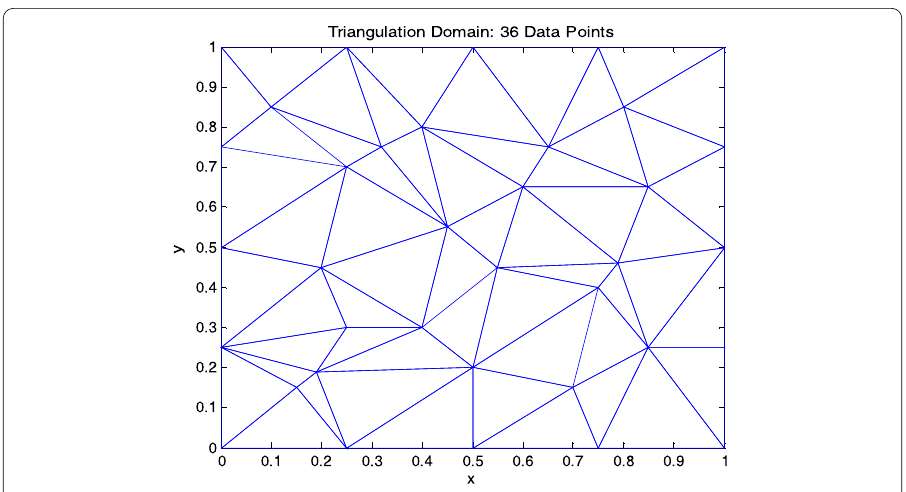
Figure 7 Triangulation domain of 36 node sets on square grid [0,1] ×